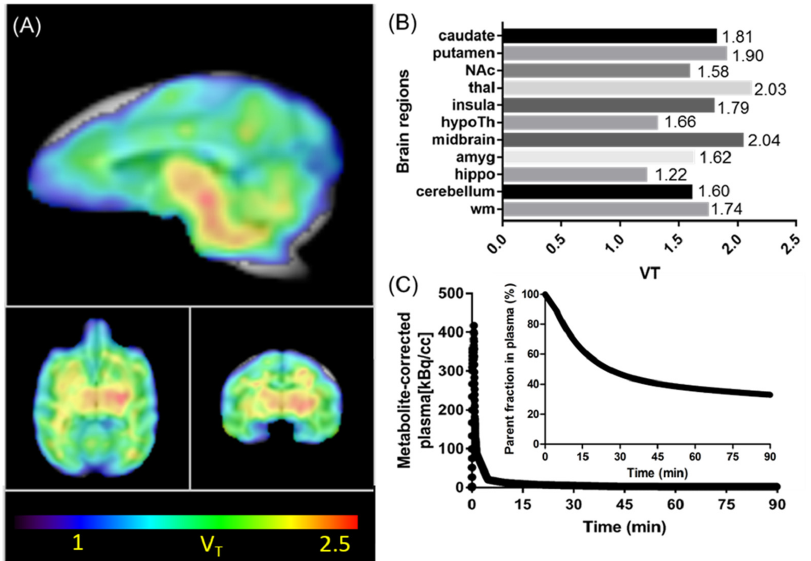
Figure 5. Kinetic modeling results with [ 11 C]CW24 in the macaque brain. ( A ) The total volume of distribution (V T ) images derived from Logan plot with arterial blood data as input function (color bar indicates V T values from 1–2.5 mL/cm 3 (blue to red); ( B ) Regional V T values showed that the expression difference in brain regions; ( C ) Arterial plasma analysis showed that [ 11 C]CW24 radioactivity was rapidly cleared from blood and [ 11 C]CW24 stability evaluated in plasma over time showed lasting presence of ~47% of parent compound at 30